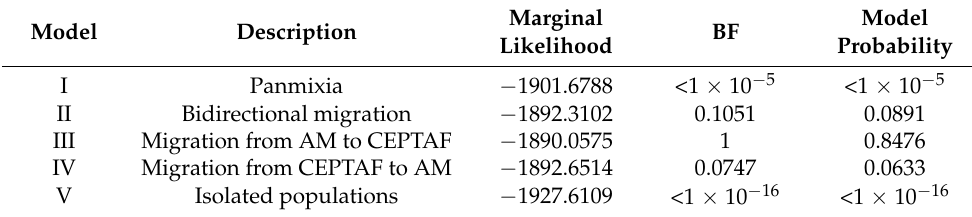
Table 1. Migration model selection through Bayes factors (BF) comparison. BFs were